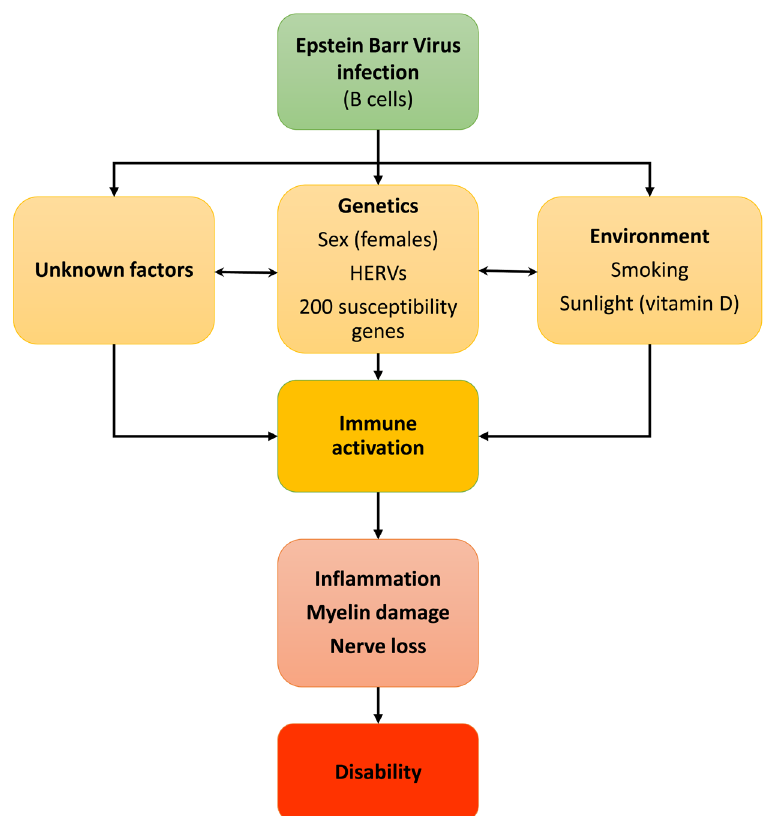
Figure 1. Causes and progression of multiple sclerosis (MS). Several studies now indicate that Epstein–Barr virus infection is necessary (but not causal) for MS to develop. Genetic factors may explain 50% of MS susceptibility whereas environmental factors together with unknowns may combine to trigger immune activation and the subsequent destruction of myelin and oligodendrocytes. This eventually leads to axonal damage and nerve cell death resulting in disability. HERV, human endogenous